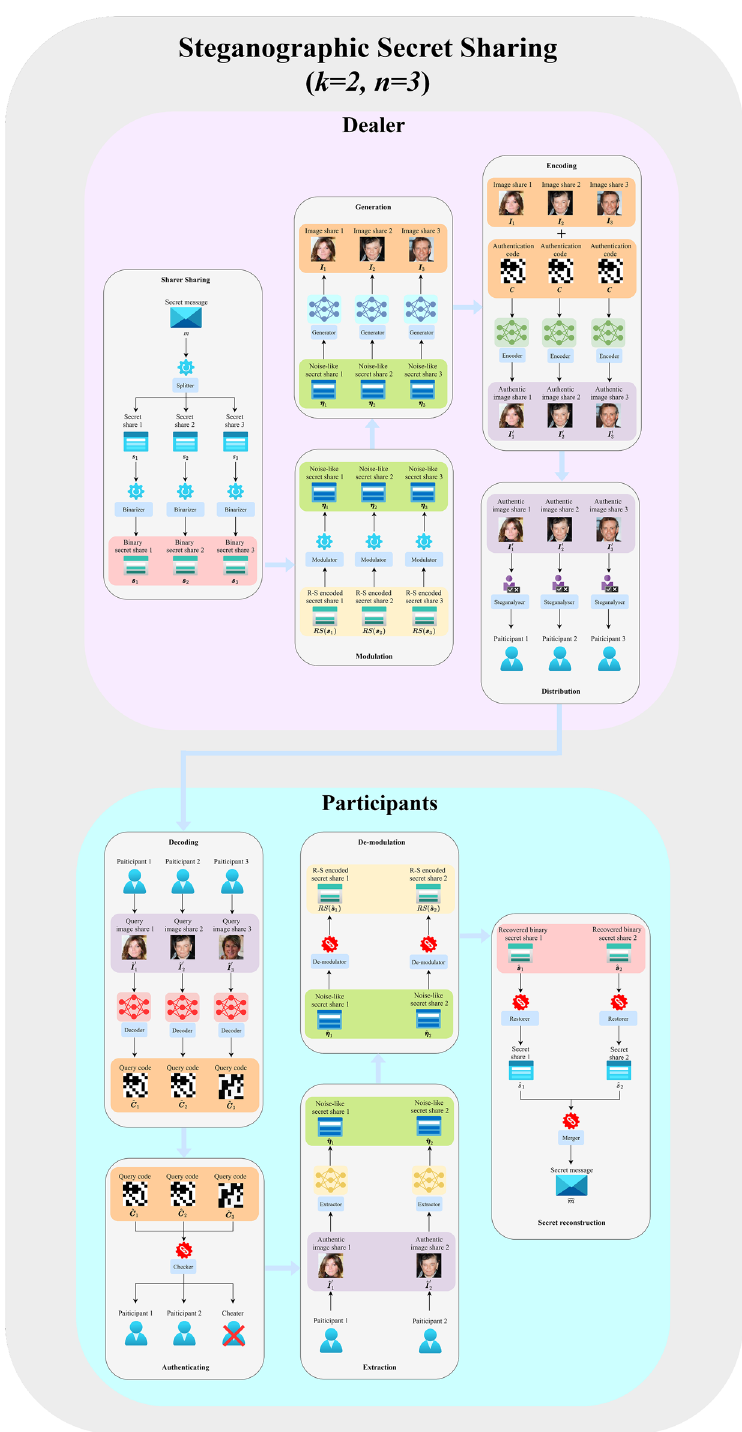
Fig. 1 Flowchart of the proposed